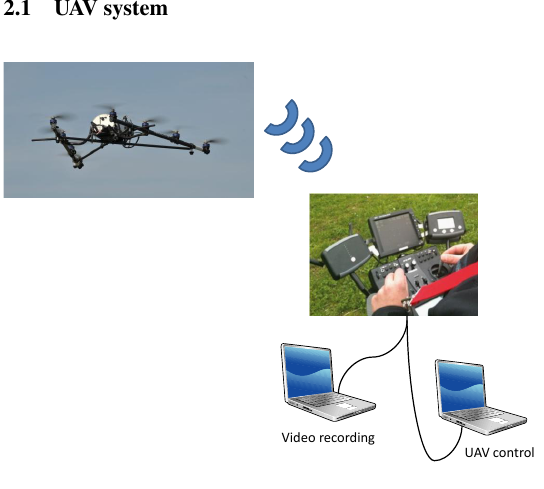
Figure 2: UAV system.